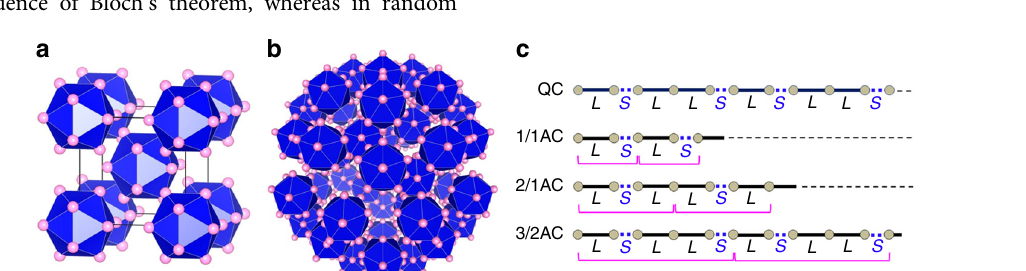
Fig. 1 Periodic and quasiperiodic arrangement of atoms. a An example of cubic unit cell in which the icosahedron occupies the corner and body-centered positions. Pink balls indicate atoms. b An example of the Tsai-type icosahedral quasicrystal. The fi vefold rotational symmetry and the self-similarity may be observed. c Fibonacci sequence and its approximants. Atoms are denoted by circles, and the long and short interatomic segment is denoted by L and S , respectively. The bracket (e.g., LS for 1/1AC and LSL for 2/1AC) denotes the unit